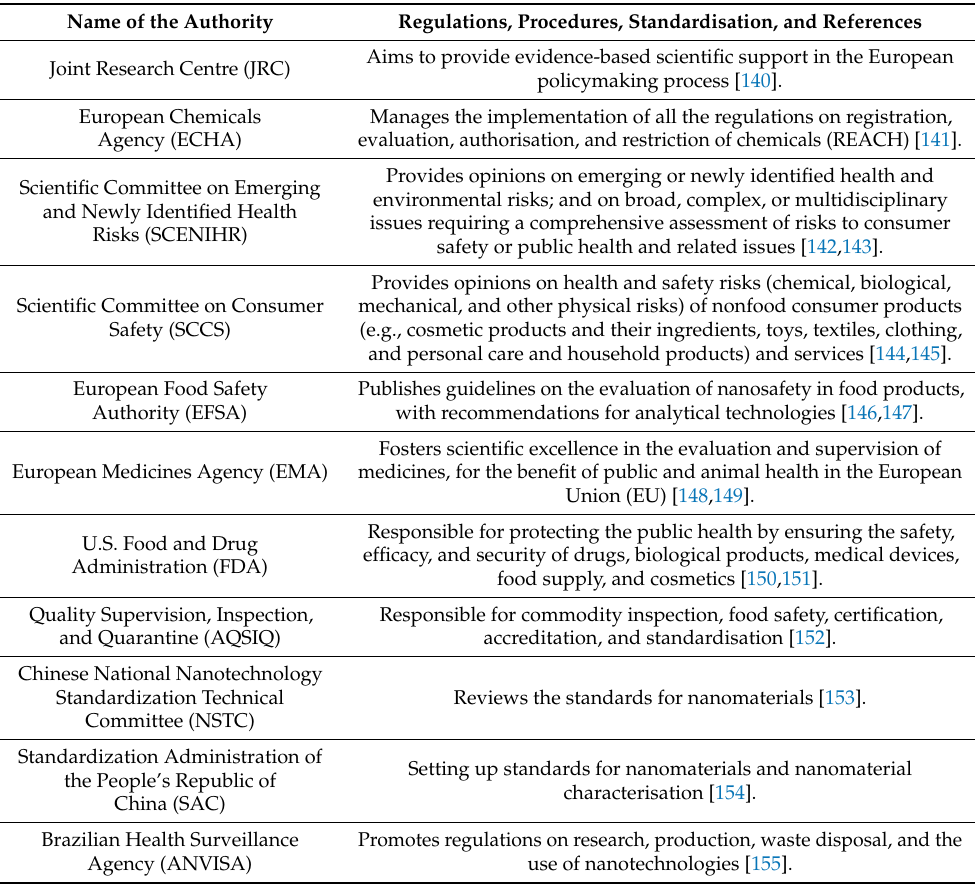
Table 3. Regulating authorities that have defined specific requirements for various groups of